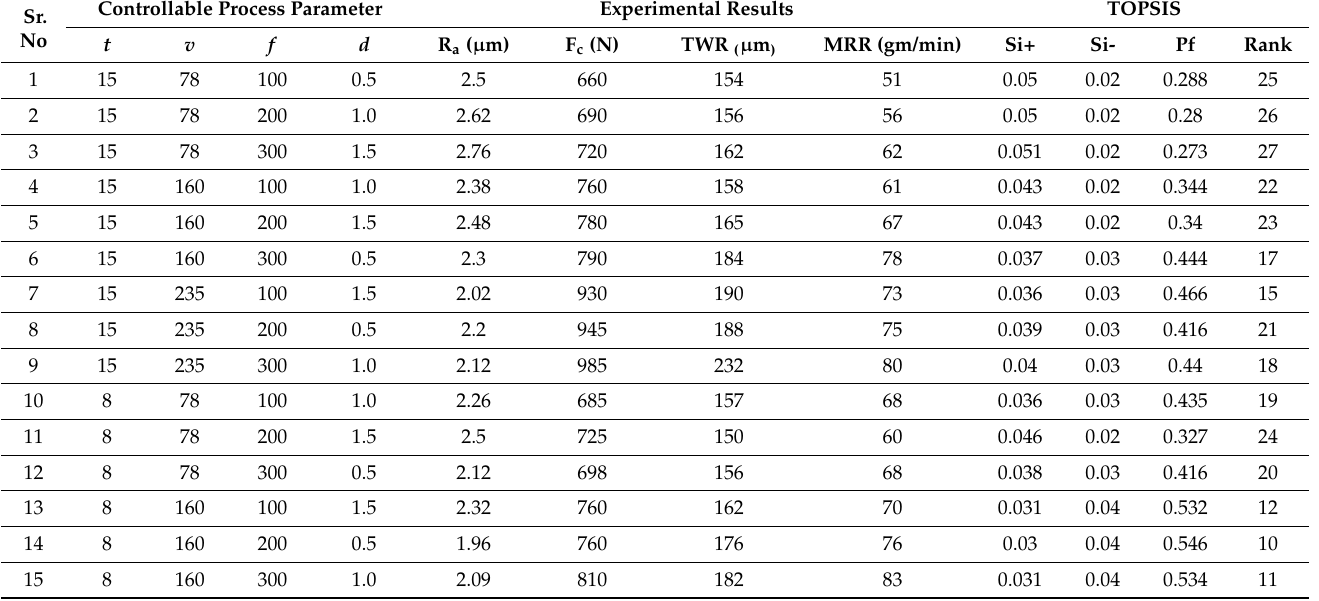
Table 7. Ranking by TOPSIS